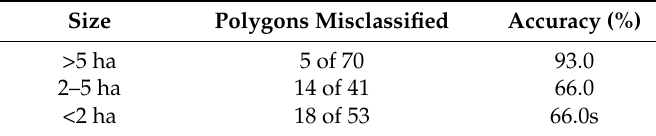
Table 3. Producer’s accuracy, by object